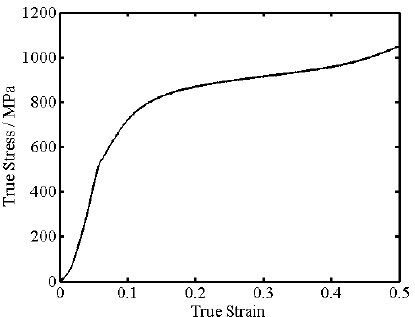
Figure 2. Stress-strain curve of ASTM 1045 steel.